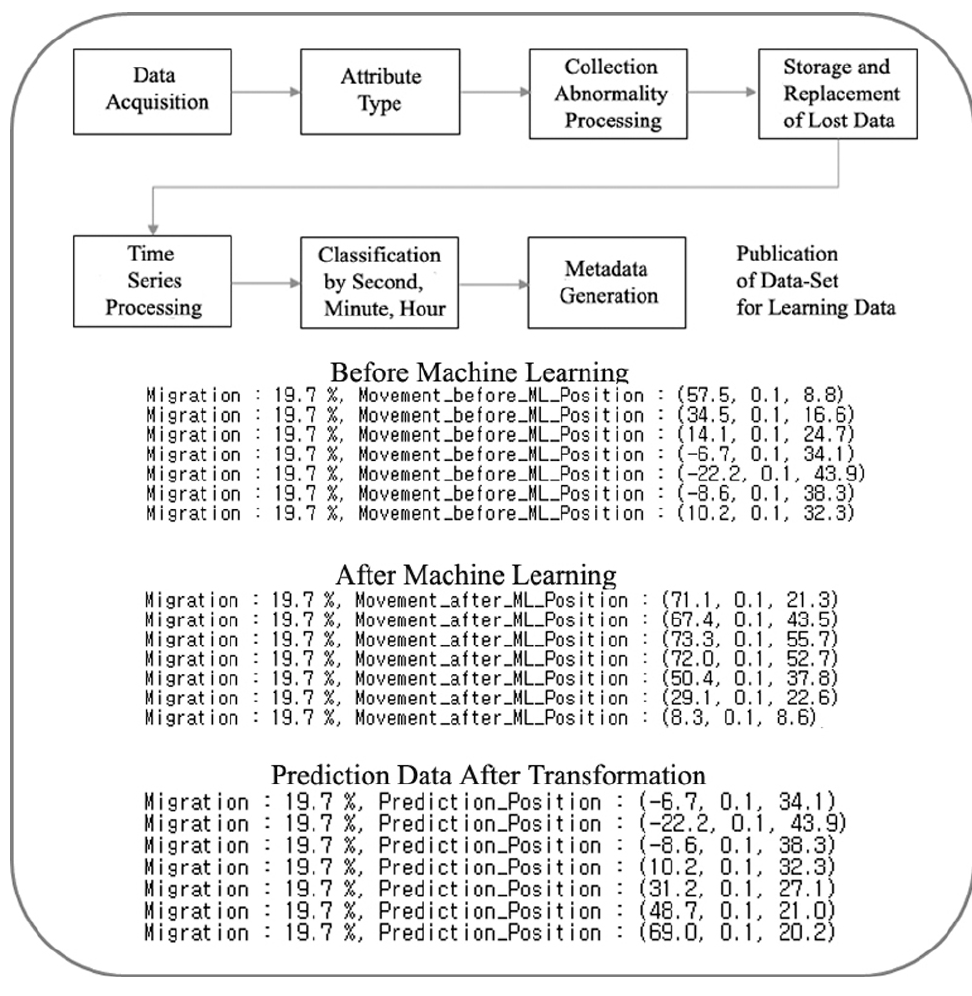
Figure 9. Machine learning sequence for the data collected from the sensor network .